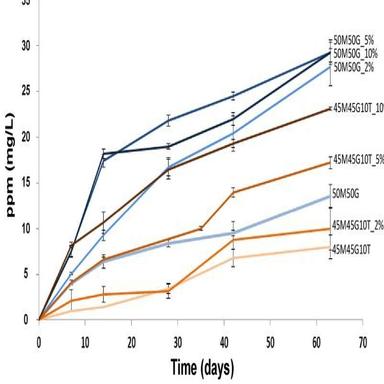
Silicon release from the coatings versus time.